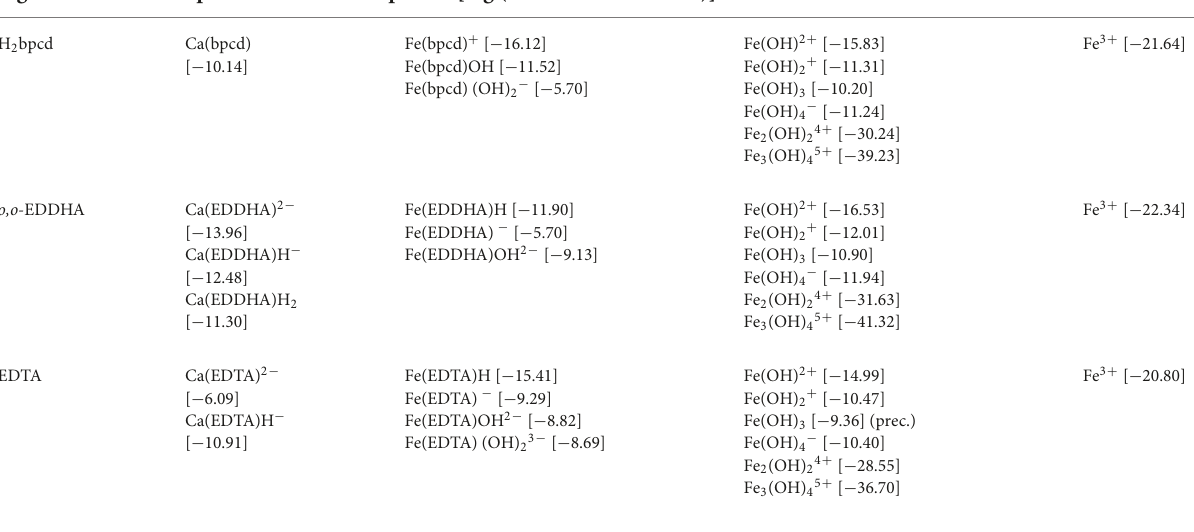
TABLE 1 The most relevant species in solution at pH = 8 in the case of the investigated ligands. Ligand Species in solution at pH = 8 [log (molar